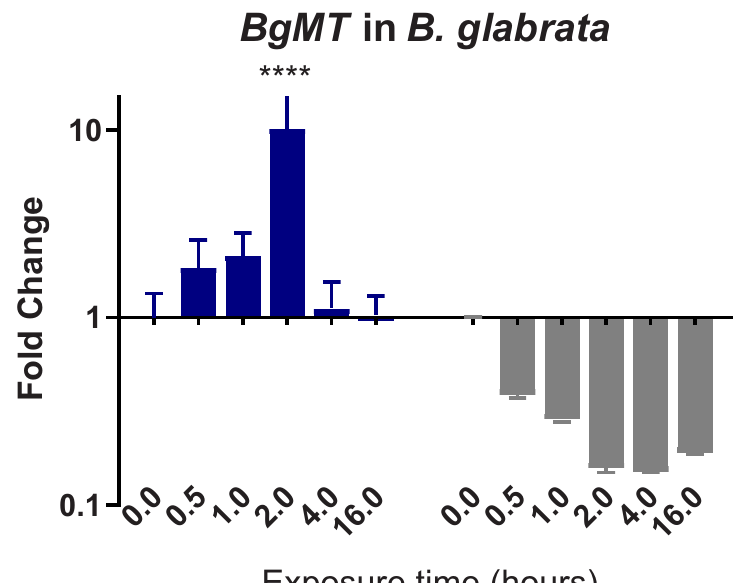
Fig 5. qPCR analysis of RNA from either resistant BS-90 (blue histogram) or susceptible BBO2 (gray histograms) juvenile snails unexposed (0) or exposed for increasing intervals (30 seconds to 16 hours) to S . mansoni miracidia. Histograms show expression of the BgMT encoding transcript in snails at each time point from five biological replicates. Note the increase in fold change in the resistant BS-90 compared to the susceptible BBO2 snails after parasite infection. Significant expression normalized against expression of the myoglobin encoding transcript was measured by 2-way ANOVA and is indicated by number of asterisks on each histogram where ���� , indicates the most significant value p � 0.0001, ��� p � 0.001, �� p � 0.01, � p � 0.05, ns p > 0.05.